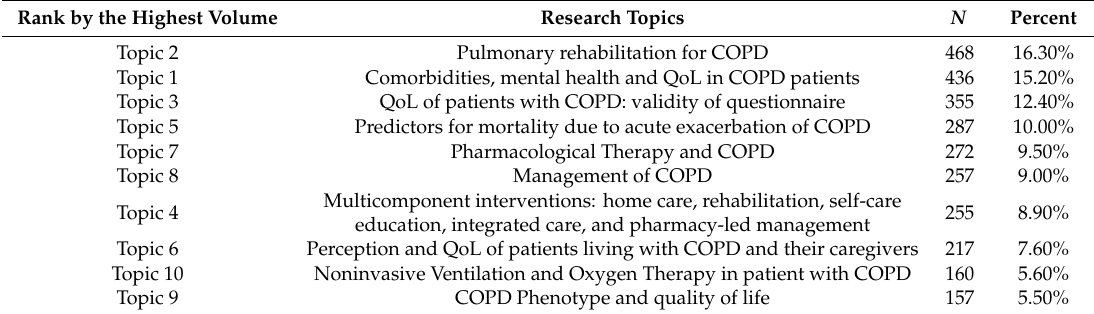
Table 4. Research topics classified by LDA.